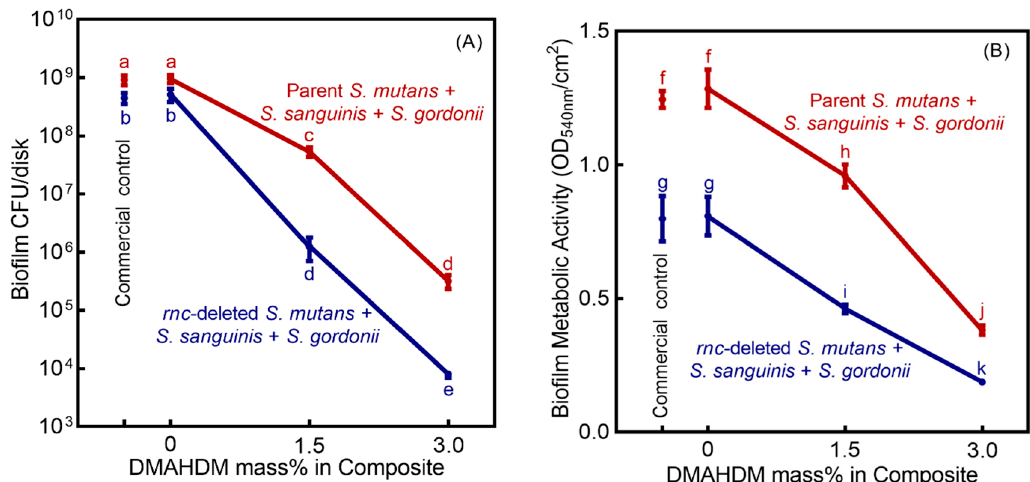
Figure 3. Antimicrobial effects of rnc knockout for S. mutans plus DMAHDM composite (mean ± SD; n = 6). ( A ) Colony-forming units (CFUs), and ( B ) 3-(4,5-dimethylthiazol-2-yl)-2,5-diphenyl tetrazolium bromide (MTT) metabolic activity of Sm + Ss + Sg biofilms on composites. Values with